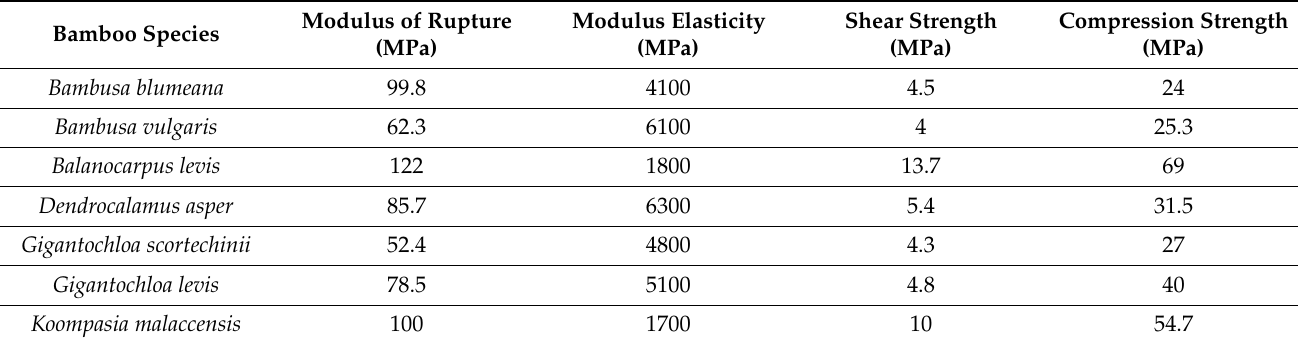
Table 5. Mechanical properties of bamboo species [70].